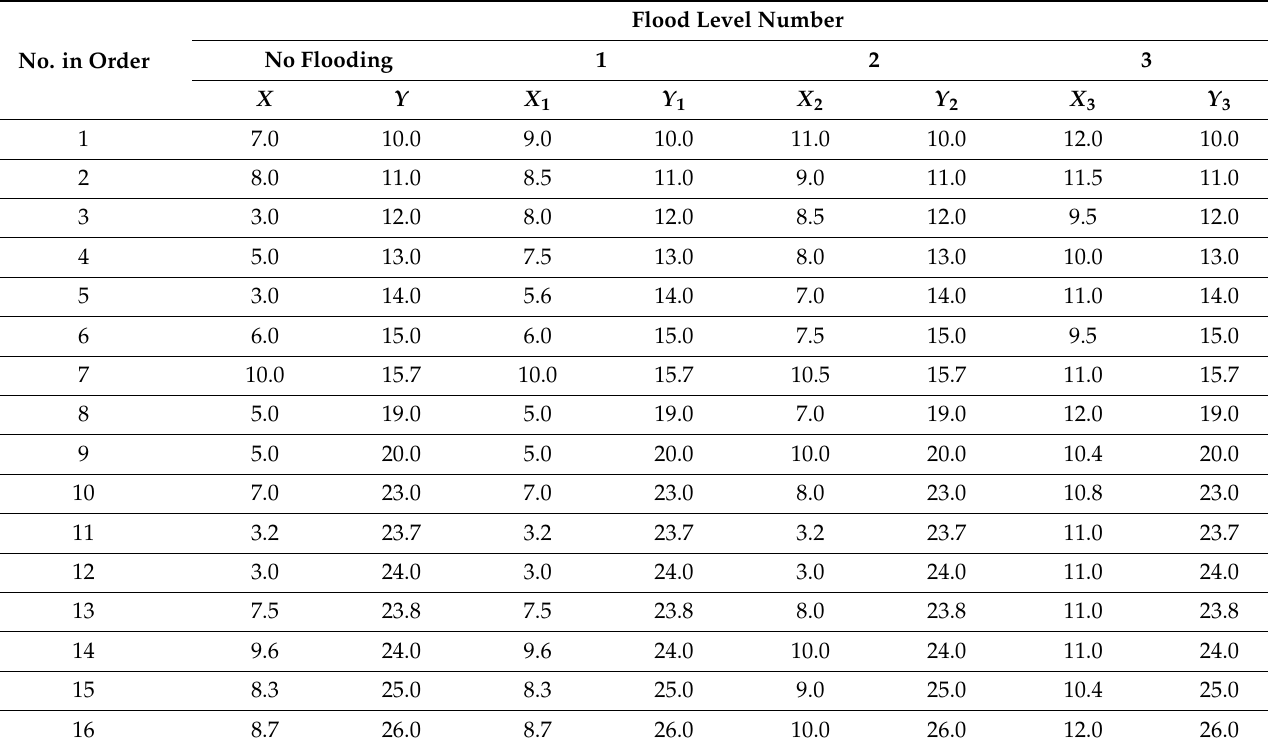
Table 2. Coordinates of the vertices of the polygon modeling the floodplain